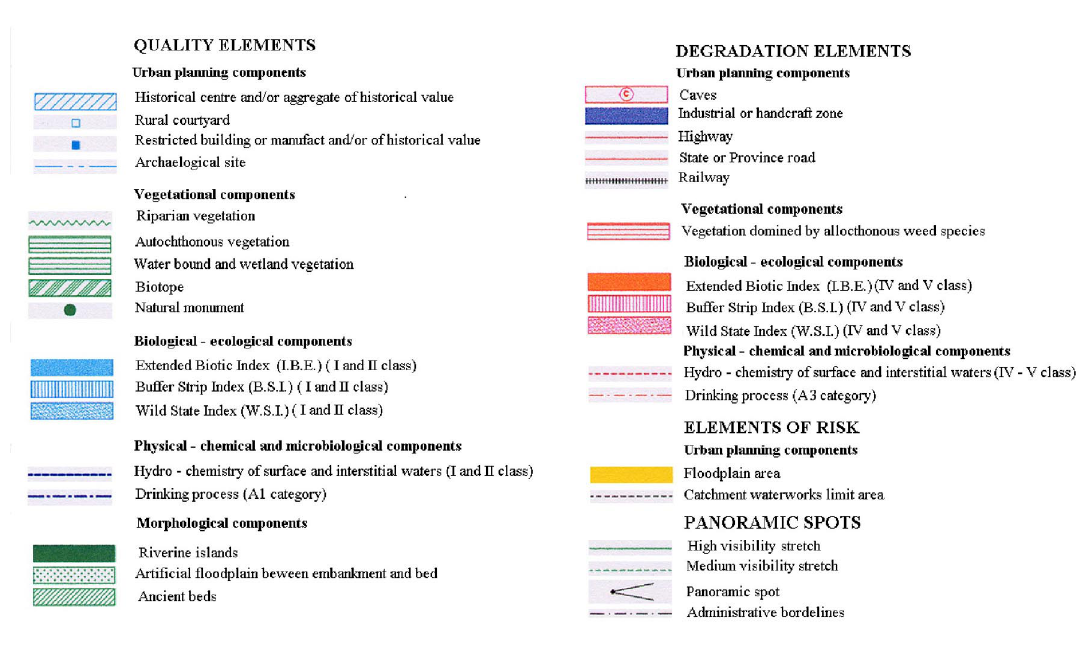
FIGURE 7. Map of quality, degradation, and risks (modified from